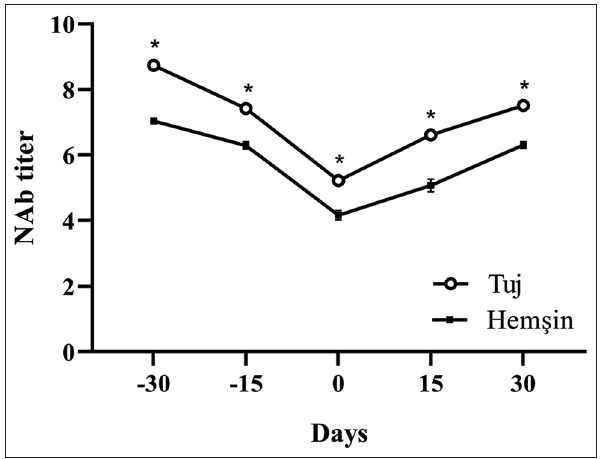
Figure-2: Serum natural antibody titer bound to keyhole limpet hemocyanin in Tuj and Hemşin sheep Table-1: Serum BHBA and NEFA concentrations in prepartum and postpartum periods in all sheep (n=50). Parameters